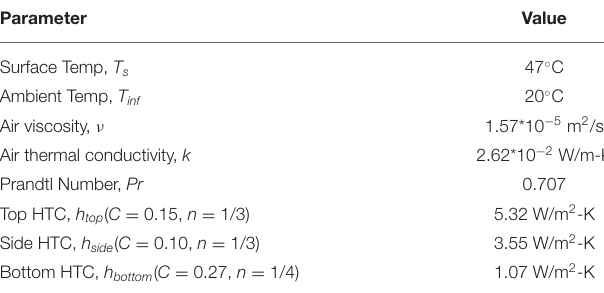
TABLE 2 | Parameters used for and results of natural convection HTC